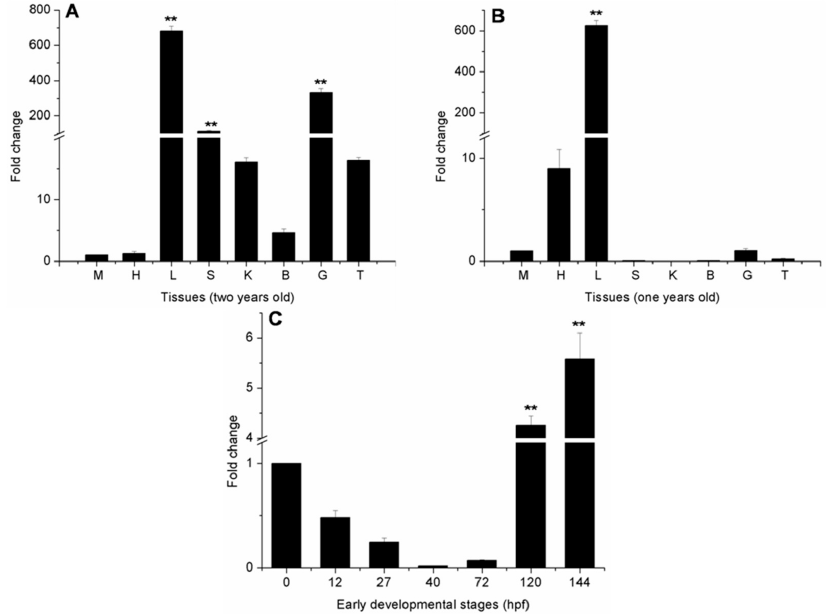
Figure 4. The expression patterns of RNase1 genes in different developmental stages and tissues of M. amblycephala . B-actin was used as reference gene. ( A ) Two-year-old fish (the muscle tissue was the same as in the control); ( B ) One-year-old fish (the muscle tissue was the same as in the control); ( C ) early different developmental stages of M. amblycephala (0 hpf egg was the same as in the control). cDNAs were used for PCR from total RNA samples obtained from the heart (H), liver (L), spleen (S), kidney (K), brain (B), muscle (M), gut (G) and testis (T) of one year and two-year-old fish, 0 (fertilized egg), 12 (late gastrula stage), 27 (heart appearance), 40 (hatching), 72 (gill circulation), 120 (air bladder formation), 144 (intestine appearance) hours post-fertilization (hpf) embryos/larvae. Differences were determined by one-way analysis of variance (ANOVA). Statistically significant differences from the control group are marked as ** p <0.01.